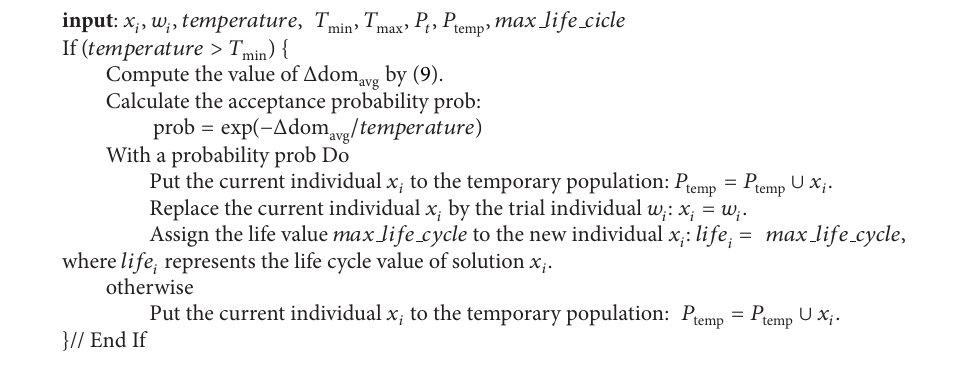
Algorithm 1: The proposed simulate annealing